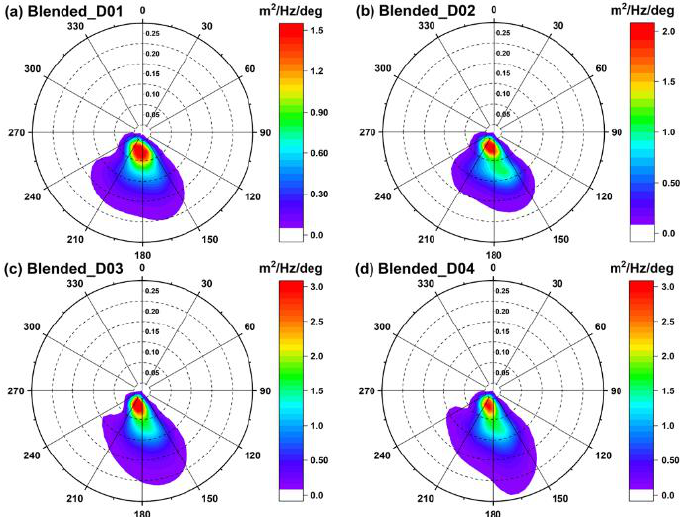
Figure 17. Comparison of the directional wave spectra at the Hualien wave buoy at 00:00 on 14 September 2016, using the four computational domains ( a – d ) and blended wind fields.